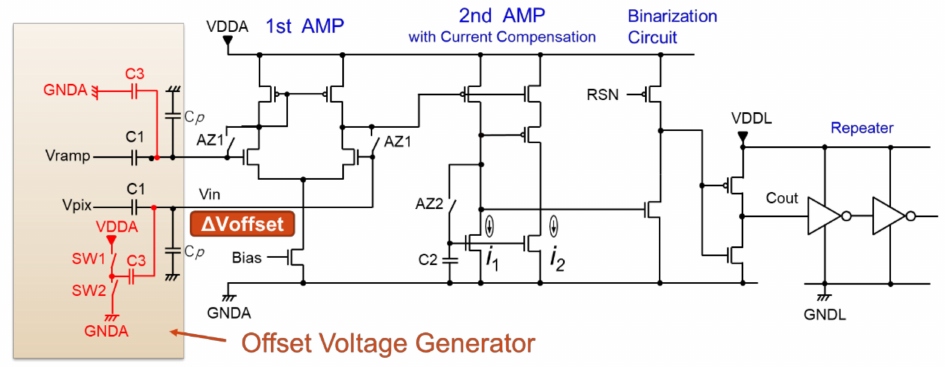
Figure 6. Circuit diagram of timing shift ADC.